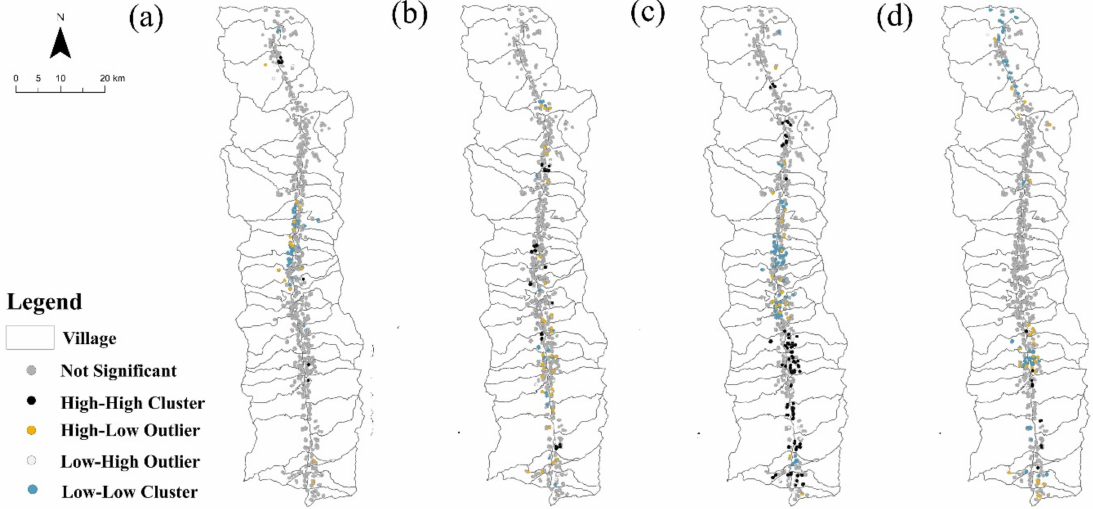
Figure 4. Lisa diagram chart of OLS residual terms of the household-level factors from 2015 to 2018 ( a – d